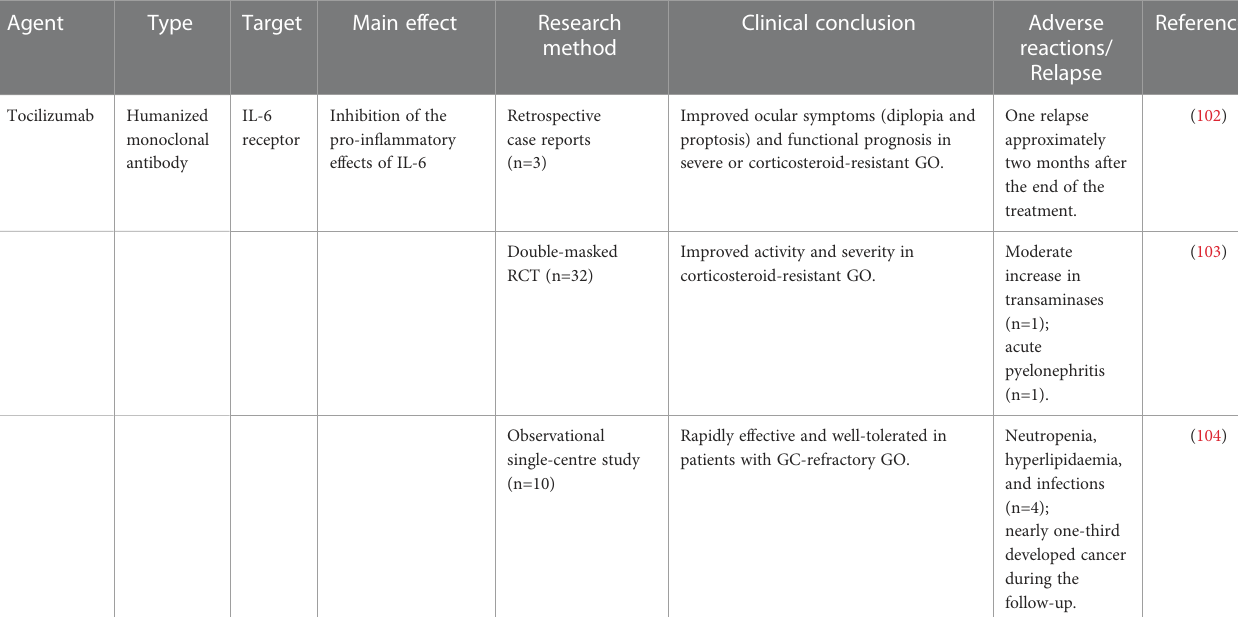
TABLE 3 Other clinical therapeutic targets for GO.